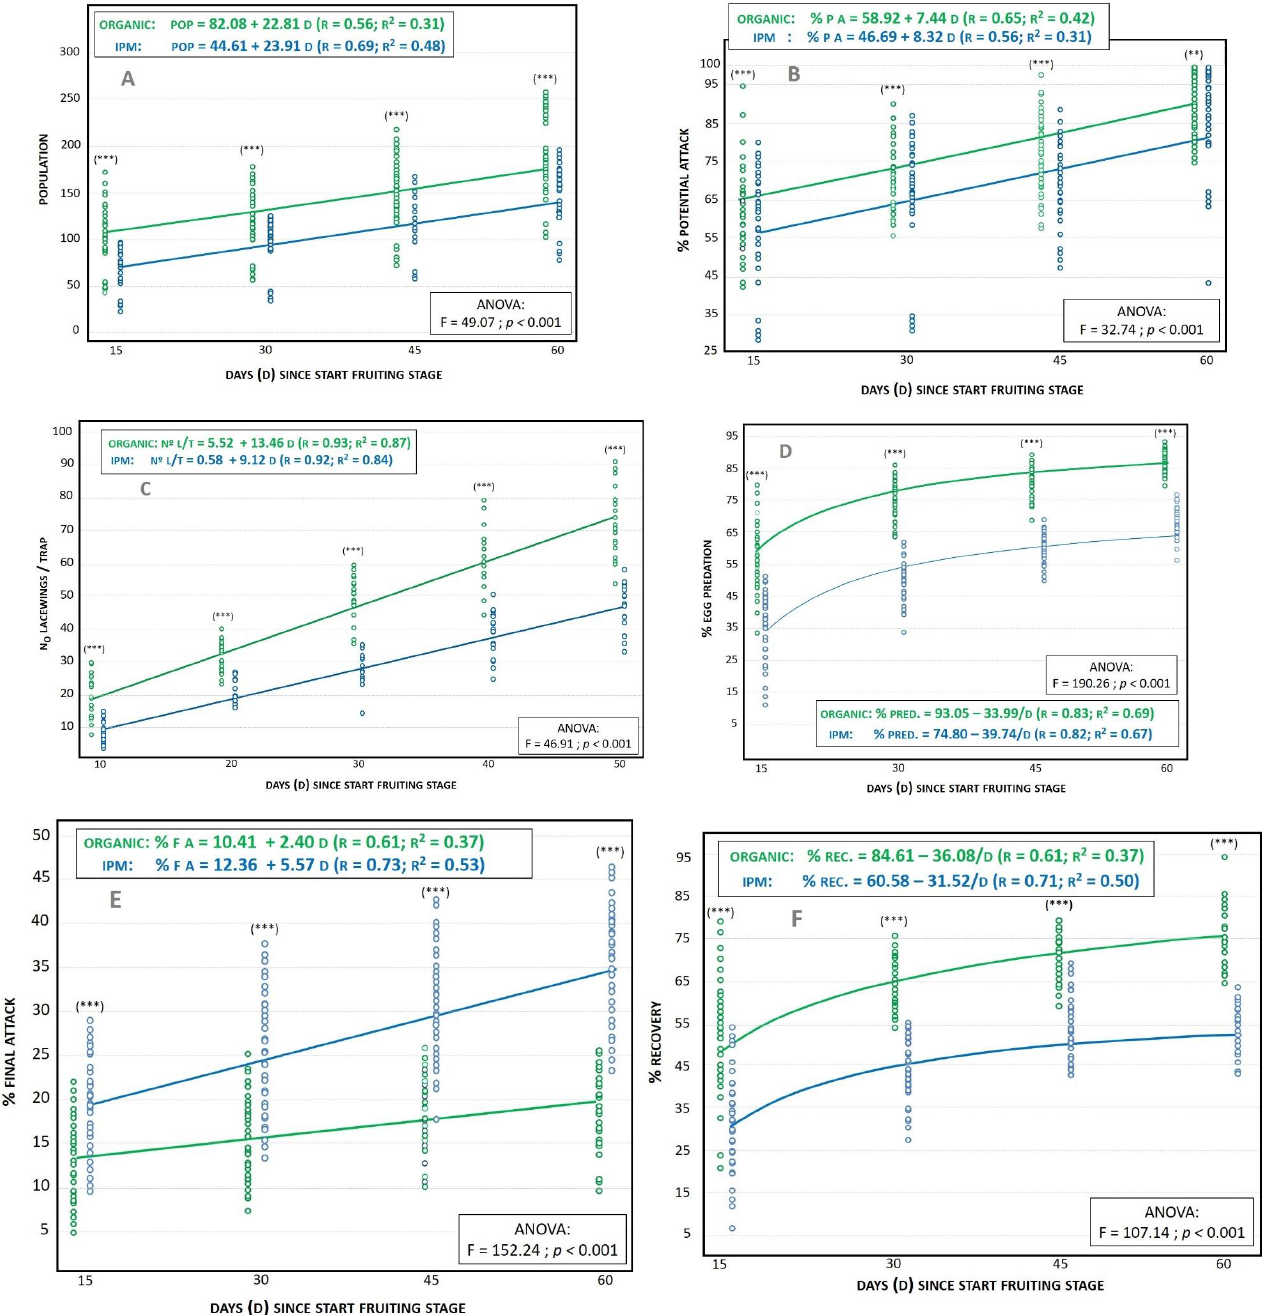
Figure 4. Regression curves of P. oleae attack parameters in pairs of plots with organic (green) and IPM (blue) management selected in southern Spain during the oviposition period. Each circle represents the value obtained in one of the olive trees selected from each plot on each sampling date. Population index (POP, ( A )); Potential Attack (%PA, ( B )). Number of captures of green lacewings in Mcphail traps ( C ). Egg predation (%PRED, ( D )). Final Attack (%FA, ( E )) and Fruit Recovery (%REC, ( F )). With asterisks, the levels of statistical significance (ANOVA; ** p < 0.01; *** p < 0.001) between sampling series corresponding to organic and IPM plots, for each sampling date, are indicated.